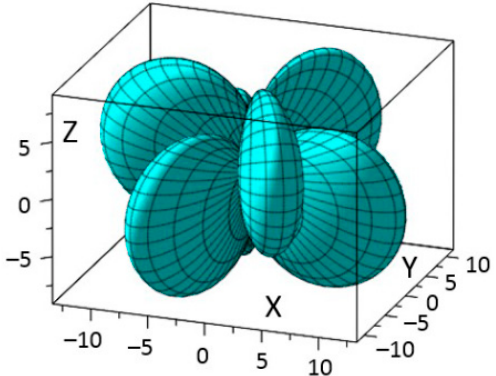
Figure 6. Schematic diagram of piezoelectric constant d 31 by the experimental data of BiFeO 3 (unit 10 − 12 C/N ).